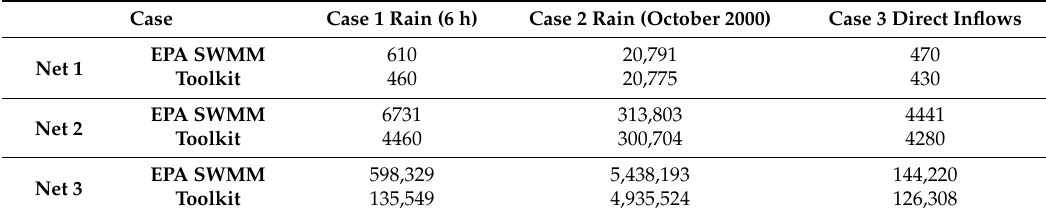
Table 2. Execution time comparison (in